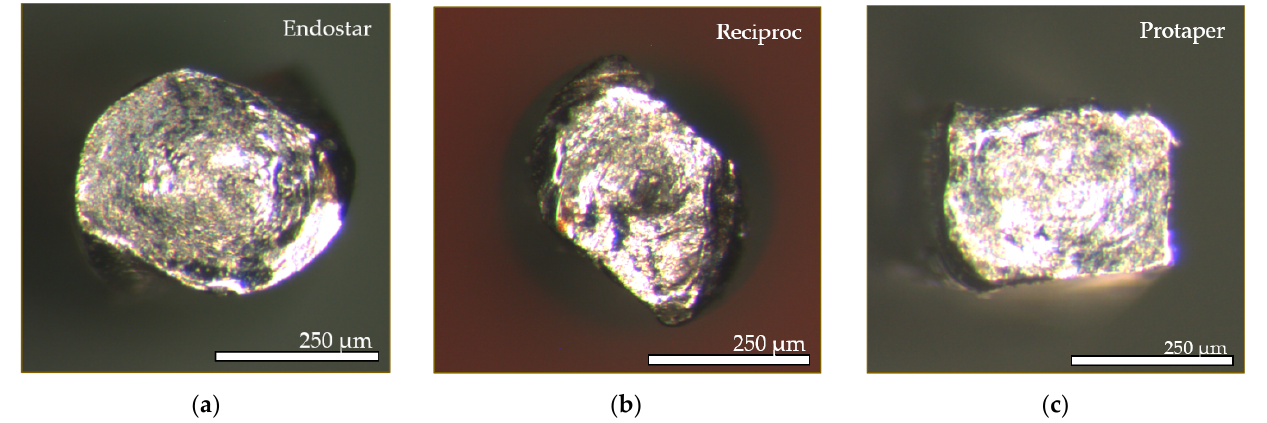
Figure 7. Fractography of the endodontic instruments: ( a ) Endostar E3, ( b ) Reciproc R 25, and ( c ) Protaper-Next X2 (i.e., an example from each of the three groups)-study carried on with optical microscopy with a 50× magnification.